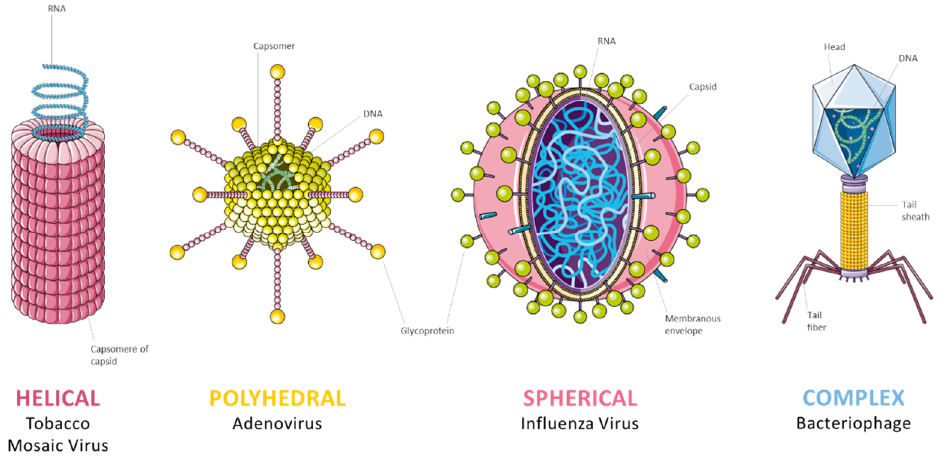
Figure 3. Types of viruses architecture.